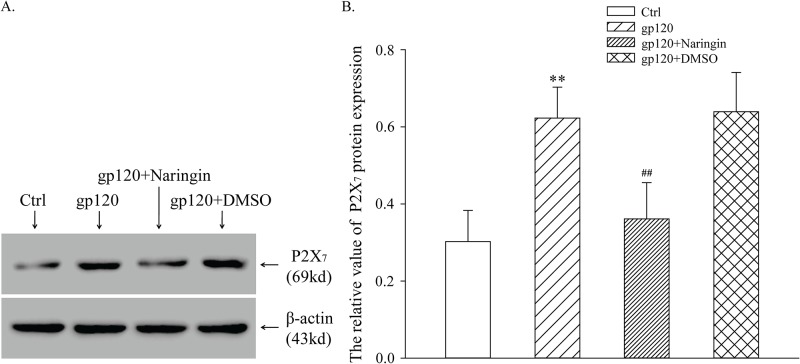
Expression of P2X7 protein measured by Western blot.A, SDS-PAGE electrophoresis of P2X7 receptor proteins in primary cultured microglia. B, Relative expression level of P2X7 receptor protein in primary cultured microglia; **P < 0.01, versus Ctrl group; ##P < 0.01, versus gp120 group; n = 5.